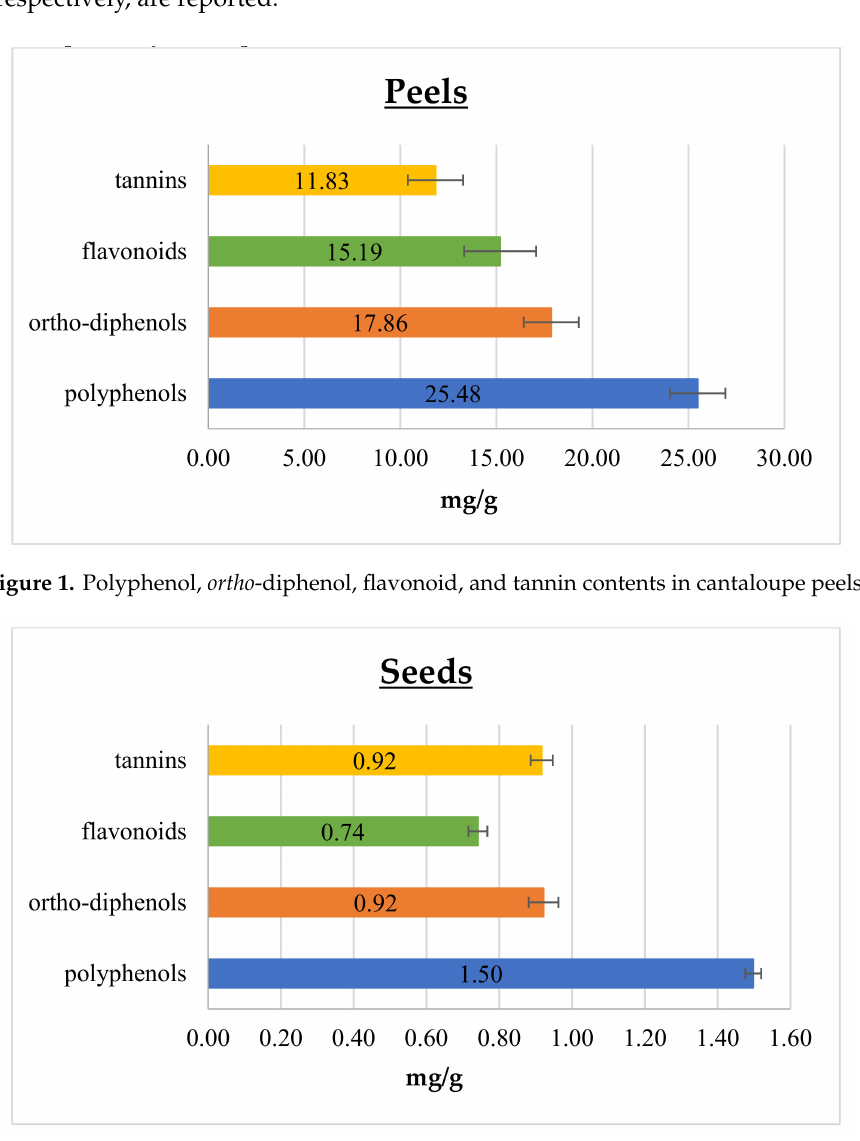
Figure 2. Polyphenol, ortho -diphenol, flavonoid, and tannin contents in cantaloupe